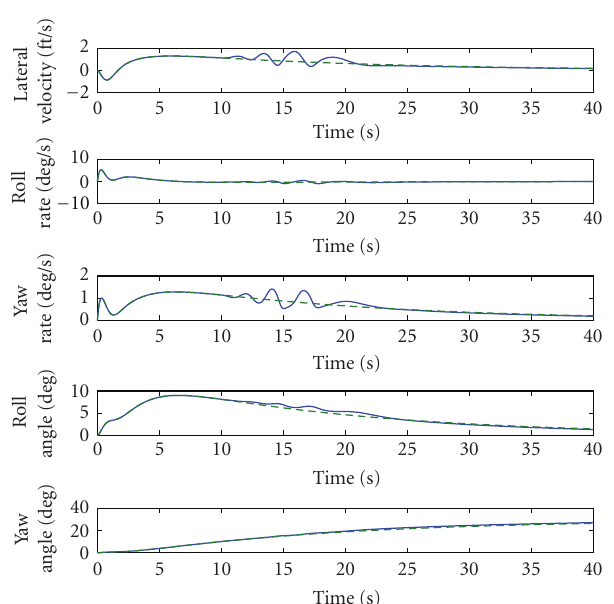
e ff ectiveness at 12 seconds. The failure magnitude and its onset time instant are unknown to the controller. The control objective is for the aircraft to achieve an accurate turn in the presence of the